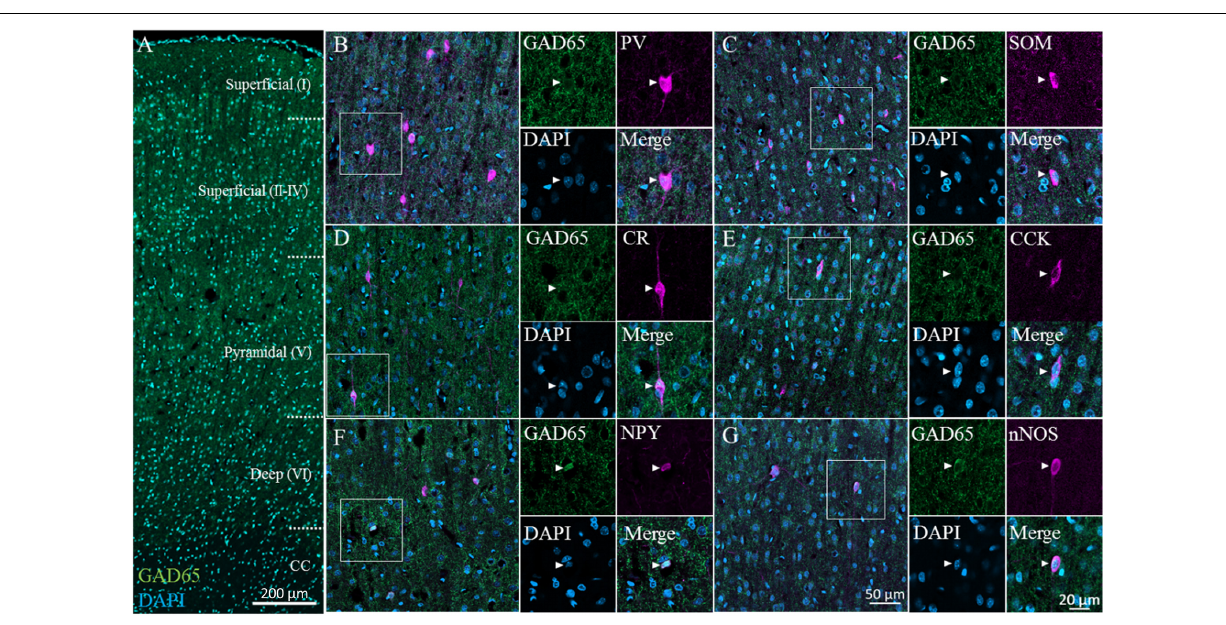
FIGURE 2 | GAD65 expression in each GABAergic subtype in the cerebral cortex. Double immunofluorescence image of GAD65 (green) and DAPI (blue) signals (A) . Triple immunofluorescence images showing GAD65 expression (green); positive signals for PV, SOM, CR, CCK, NPY, or nNOS (magenta); and DAPI staining (blue) in the superficial (II–IV) layer (B–G) . White squares indicate the regions enlarged in the panels on the right, and arrowheads indicate